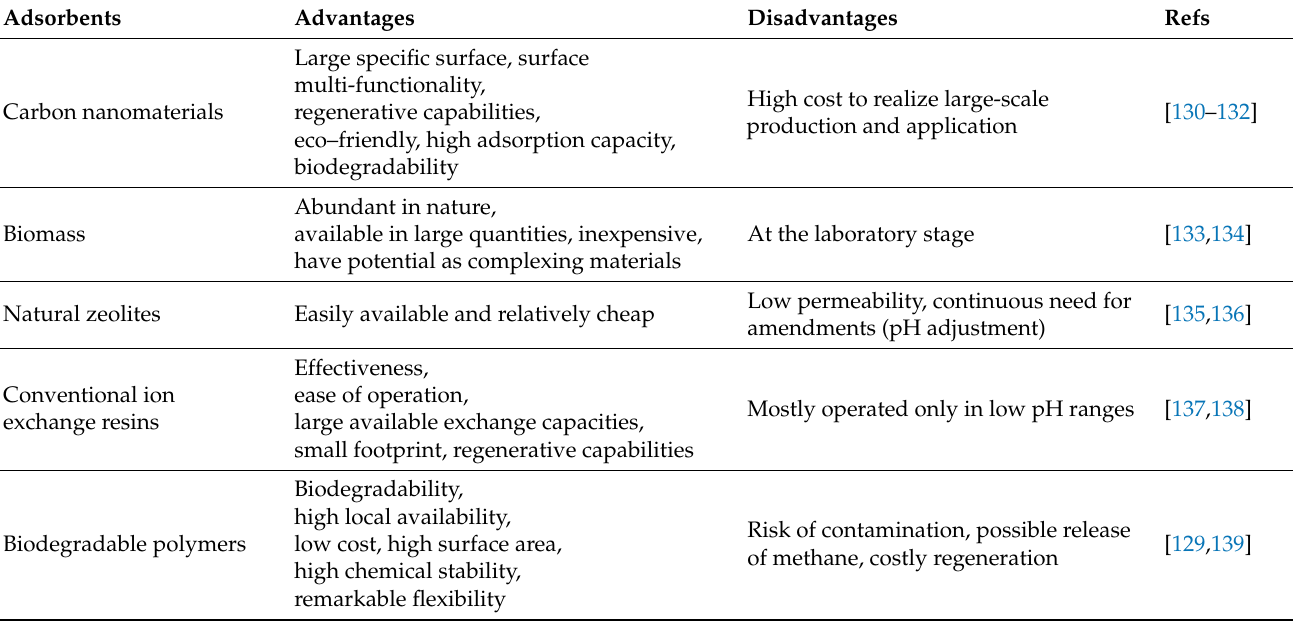
Table 4. Comparison with other materials of EDC